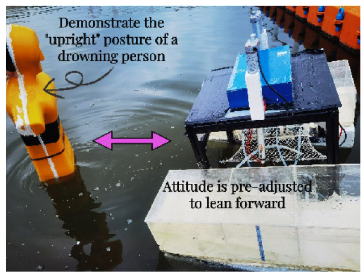
Figure 8. Experimental procedure (a).